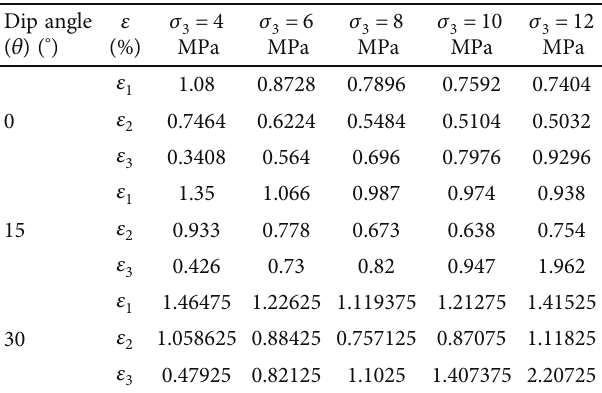
Table 2: Strain of each principal stress direction under di ff erent triaxial stresses and fracture dip angles.